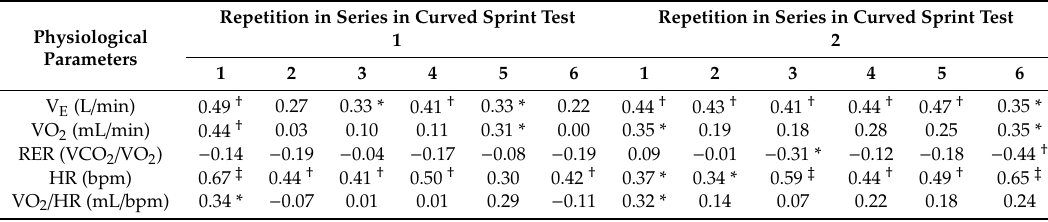
Table 7. Correlation coe ffi cients between the time of repetitions of CST and physiological parameters at the predicted VO 2max level in the Yo-Yo